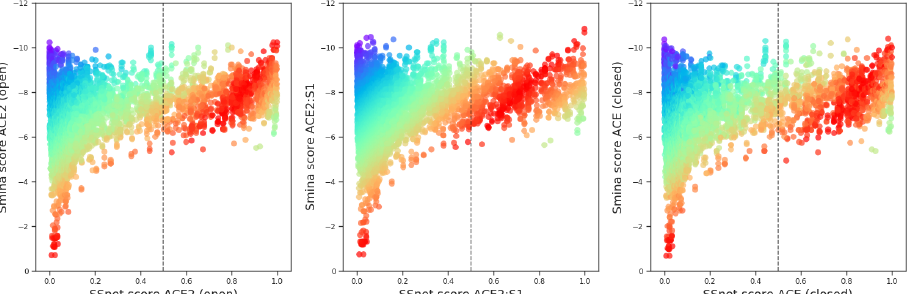
Figure 3. Correlation map between smina binding affinities and SSnet scores. Red color indicates strong agreement between the two methods. Blue color indicates strong disagreement between the two